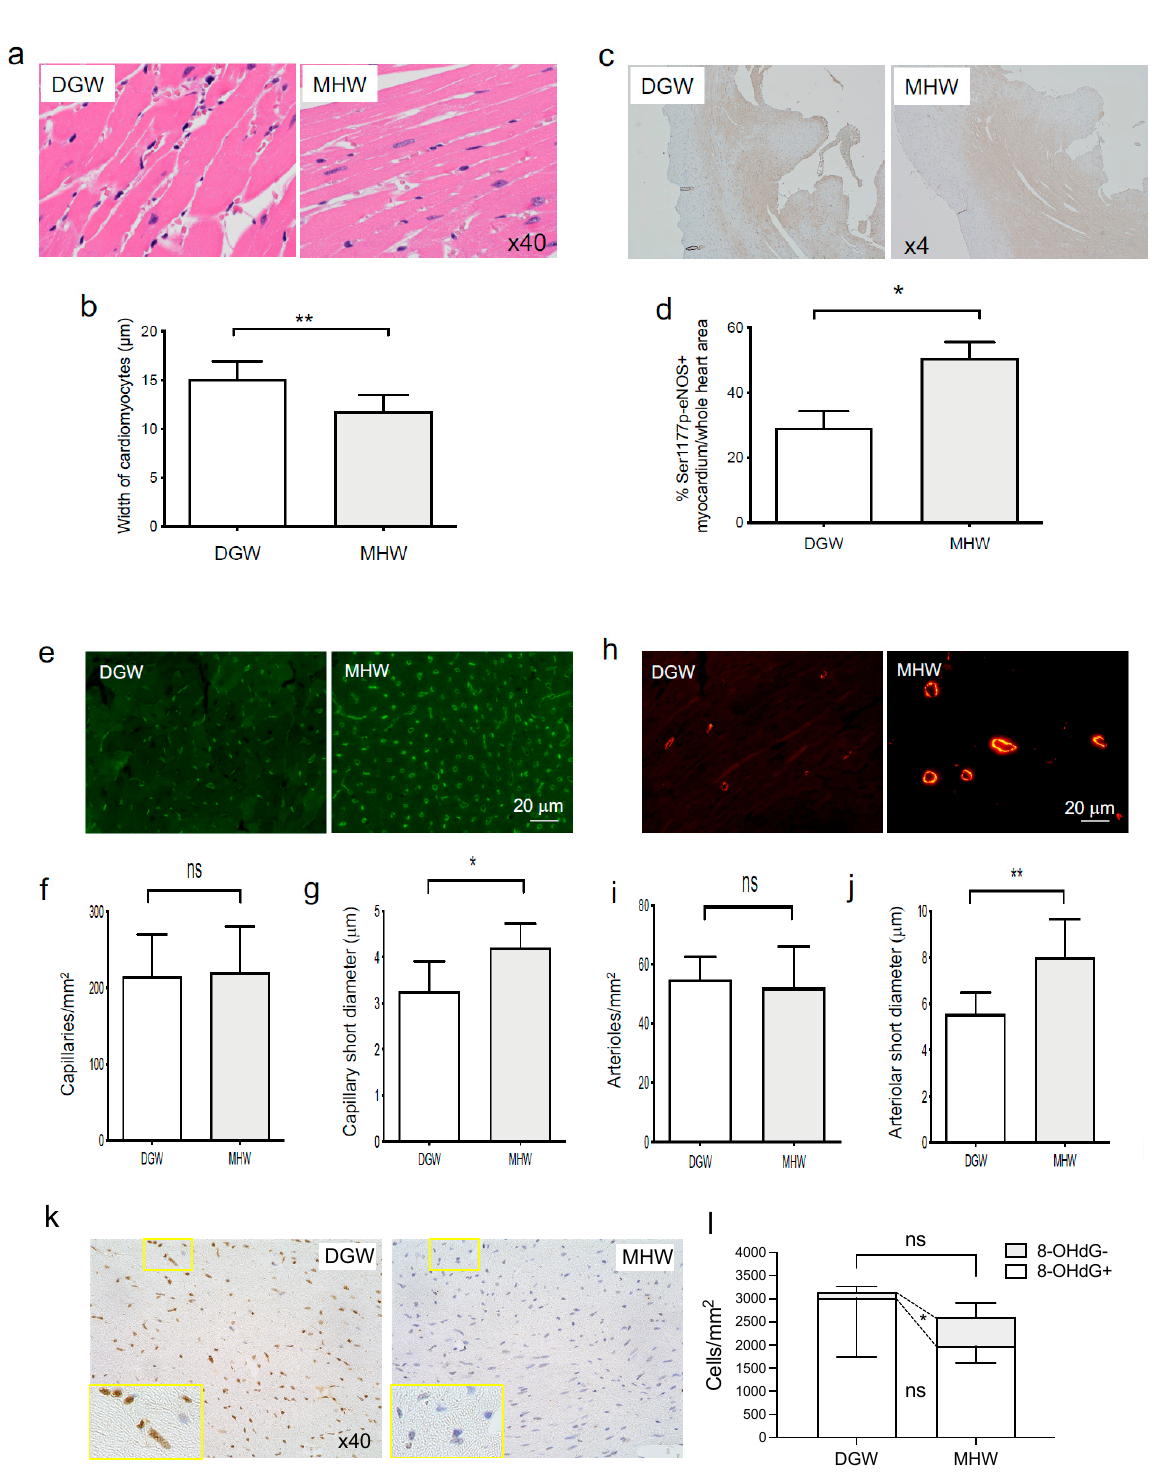
Figure 5. The morphological features of the hearts of DIO mice drinking MHW for 14 days. ( a , b ) H&E staining features and widths of the cardiomyocytes of DIO mice in the DGW or MHW group. The bar graph indicates the width of cardiomyocytes in each image. n = 7 or 8; ** p < 0.01. ( c , d ) Cross ‐ sectional H&E ‐ stained images of LV Ser1177p ‐ eNOS + myocar ‐ dium. The bar graph indicates the percentage of the Ser1177p ‐ eNOS + myocardium area to the cardiac area in each image. n = 4 or 5; * p < 0.05. ( e , f , g ) Cross ‐ sectional images of LV capillaries stained with isolectin B4 ‐ Alexa Fluor 488. The bar